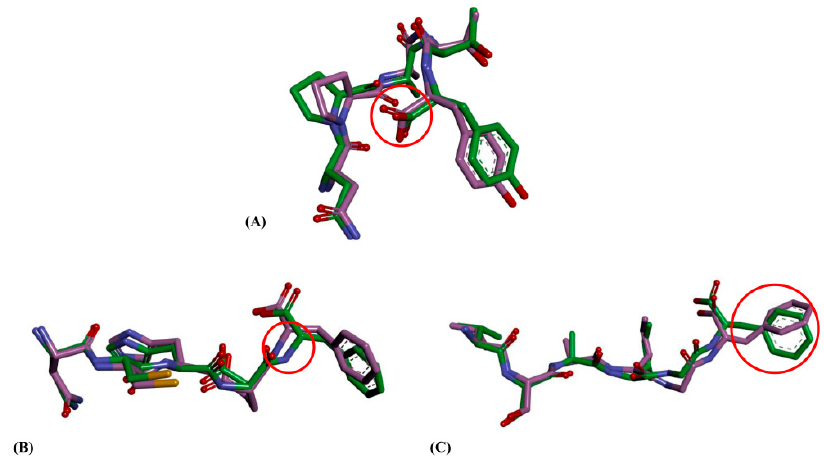
Figure 8. Conformational changes of first active amino acids in C ‐ terminal of ligands: ( A ) conformational changes of NPATY from 5.70 to 5.71 ns; ( B ) conformational changes of VSAIGF from 1.39 to 1.40 ns; and ( C ) conformational changes of NCHEF from 12.05 to 12.06 ns. The conformational changes were from green conformation to pink conformation. The red circles represent the important differences in active amino acids.